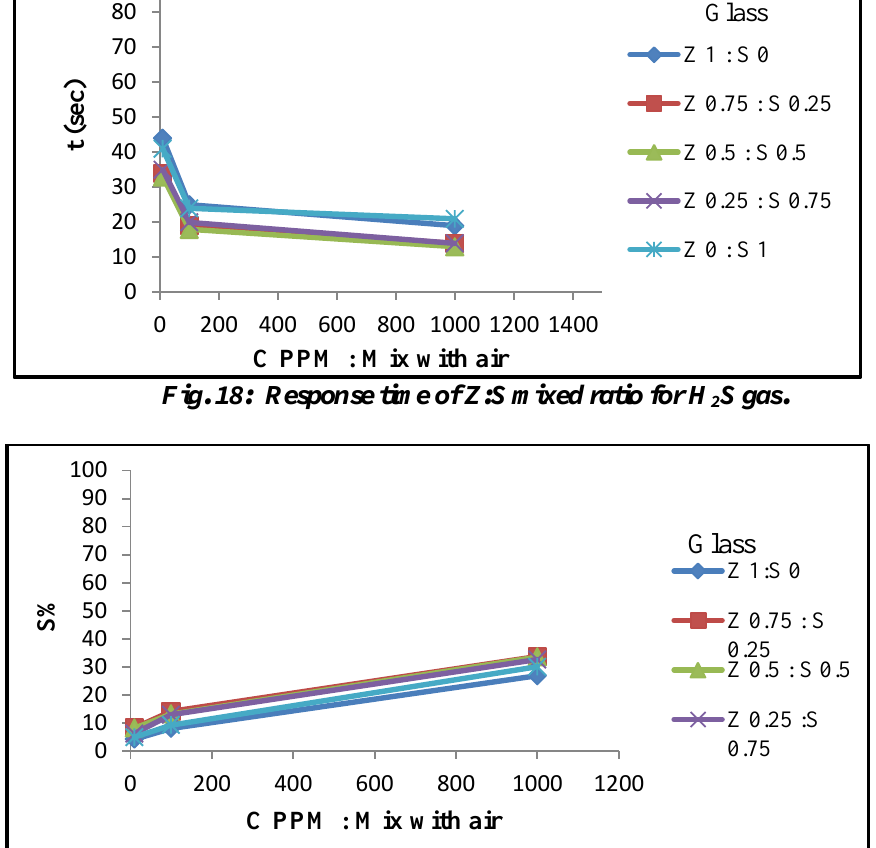
Fig. 19: Gas sensitivity of CH